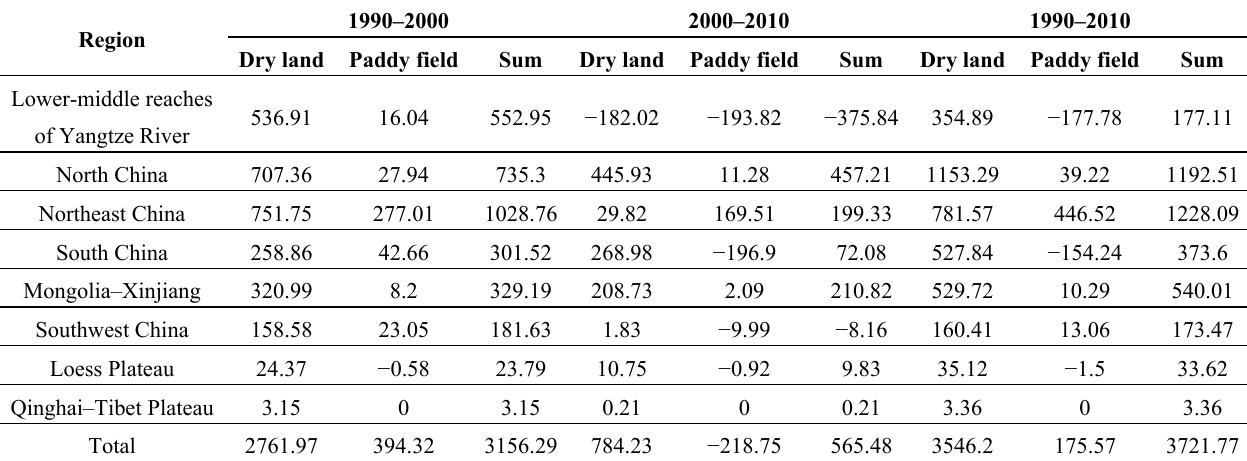
Table 6. Changes in CR in various regions of China from 1990 to 2000 (units, 1 × 10 4 t). E